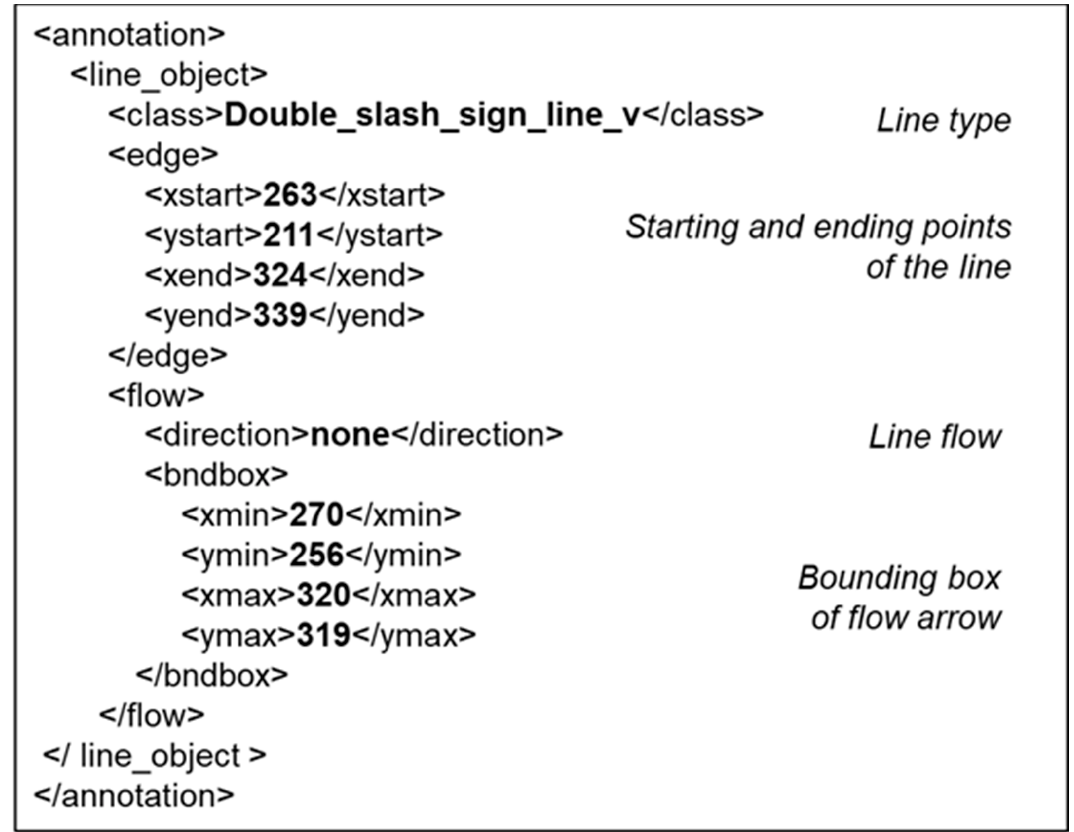
Figure 17. Line recognition data format.